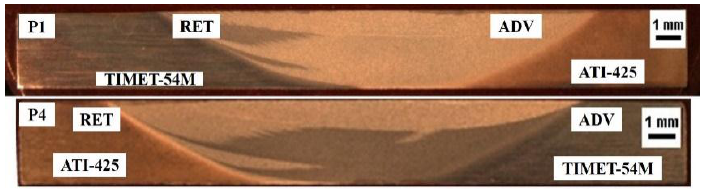
Figure 5. Typical macrographs of butt welds, (P1) ATI-425 on the advancing side, and (P4) TIMET- 54M on the advancing side. RET: Retreating; and ADV: Advancing side.